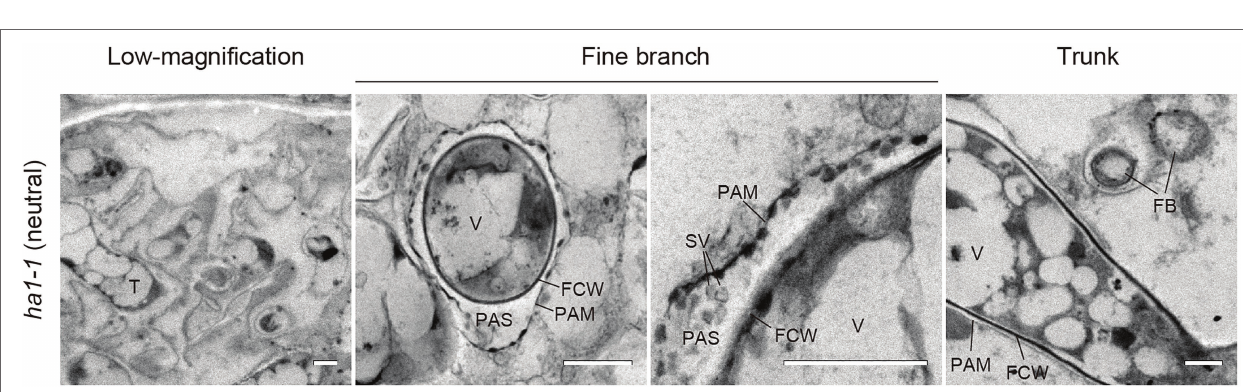
Frontiers in Plant Science | www.frontiersin.org